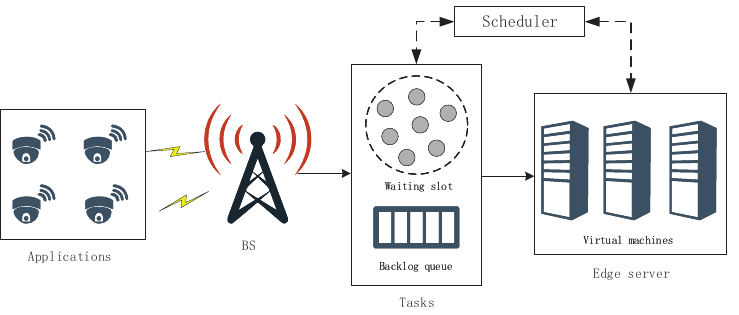
Figure 1. Illustration of the system